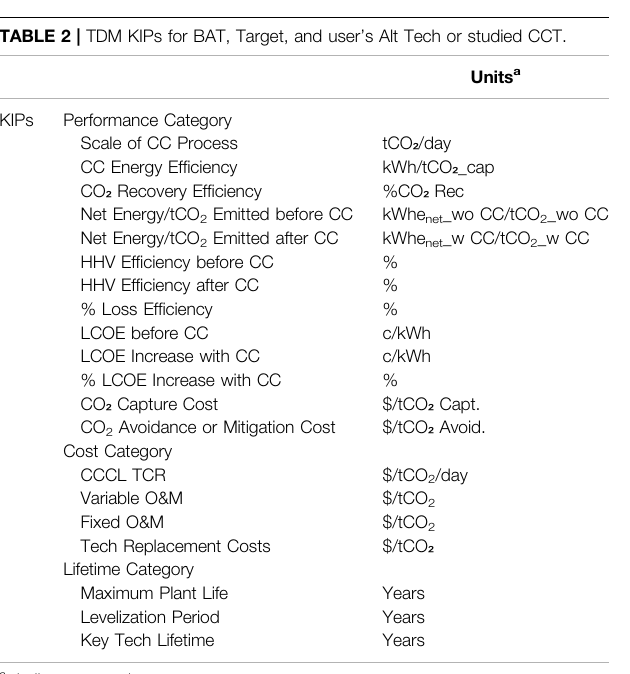
TABLE 2 | TDM KIPs for BAT, Target, and user ’ s Alt Tech or studied CCT.